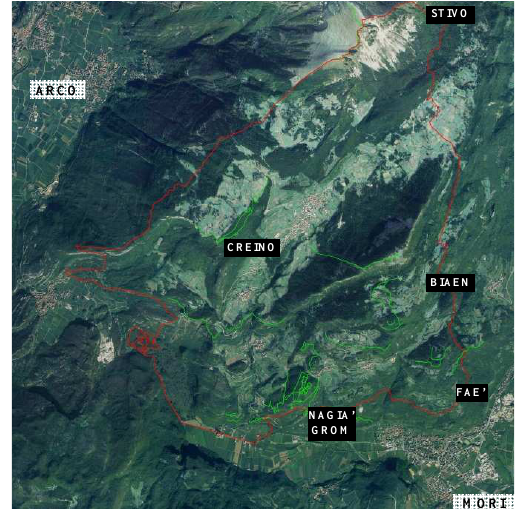
Figure 1. The study area: Val di Gresta -Italy.